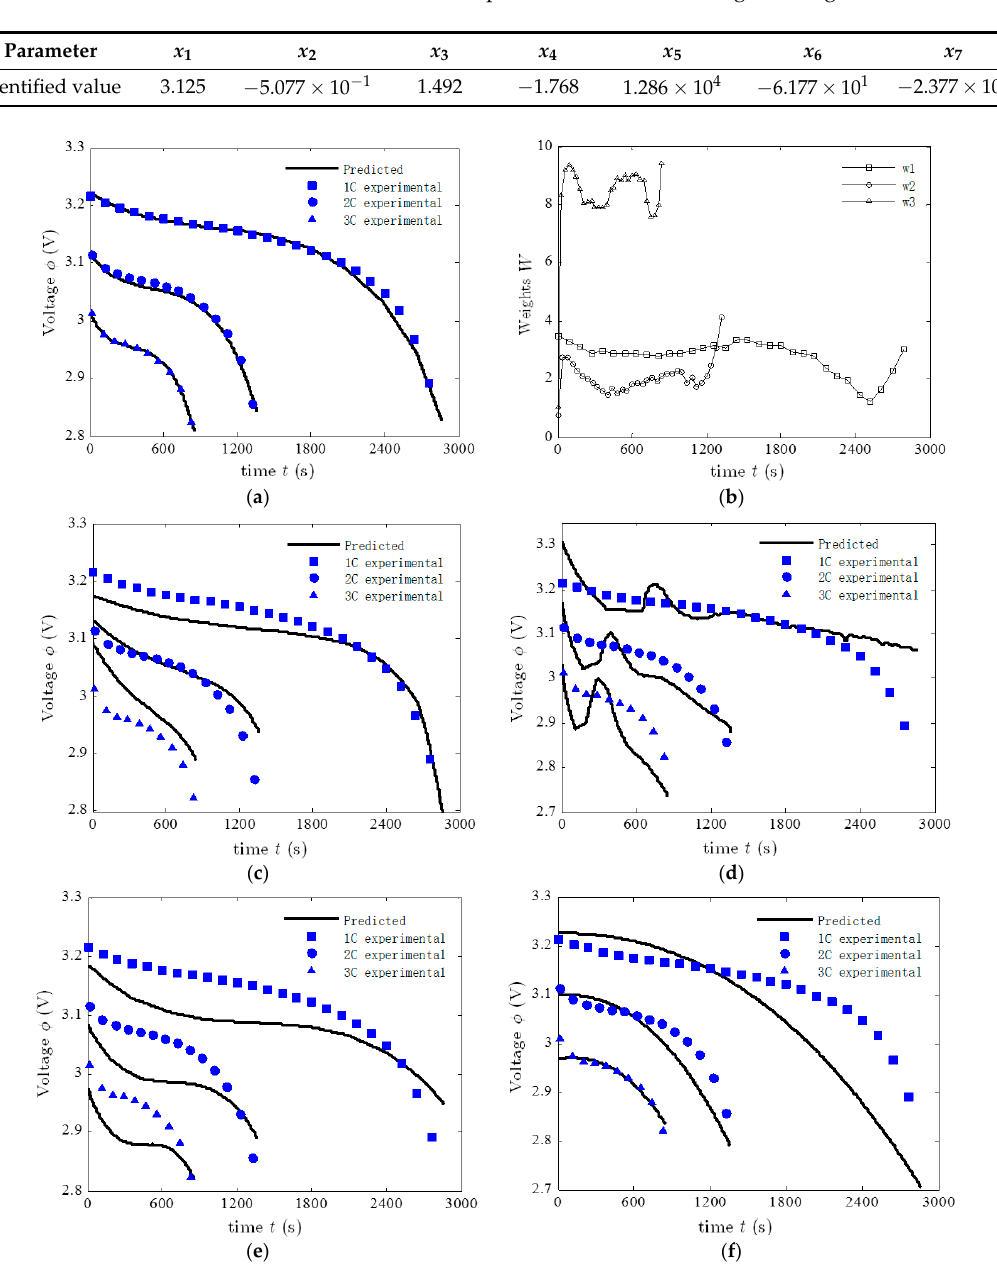
Figure 5. Comparison between experimental and predicted discharge voltage curves at discharge rates of 1C, 2C, and 3C using three different identified algorithms: ( a ) weighted PSO-LM; ( b ) trajectory of the weight matrix W = diag { w 1 , w 2 , w 3 } ; ( c ) PSO-LM with W = diag { 1,1,1 } ; ( d ) PSO; ( e ) LM and ( f ) method of trial and error.